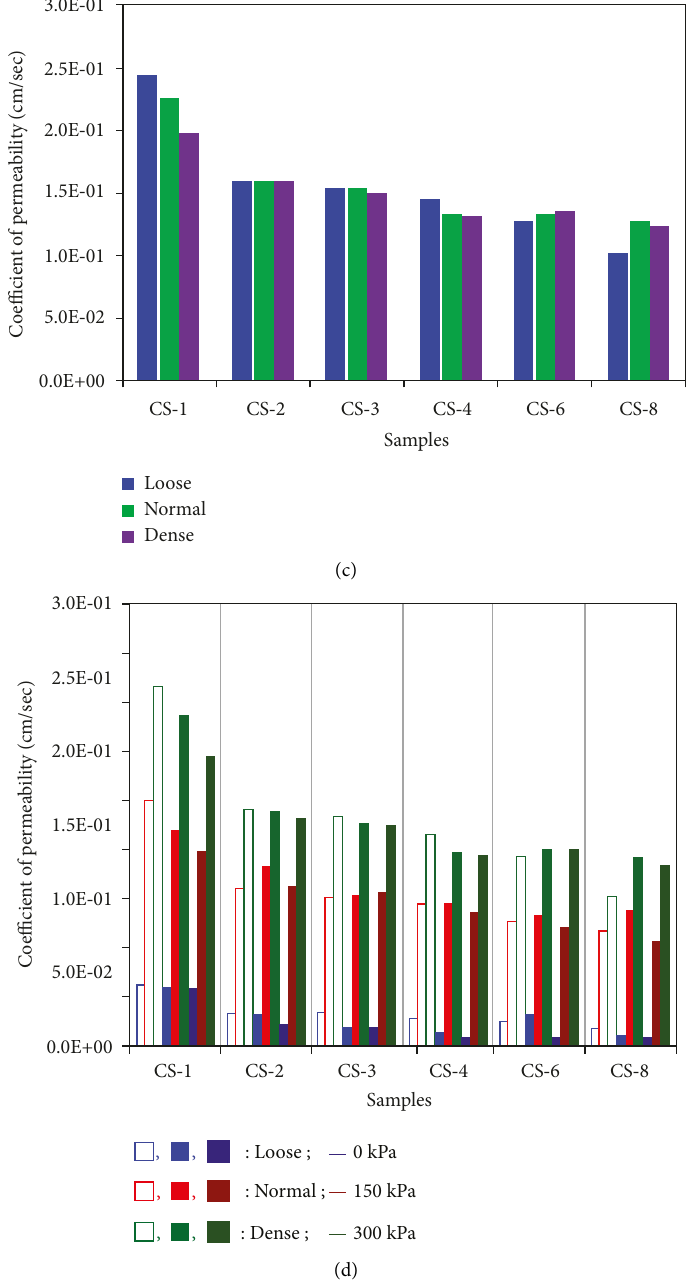
Figure 9: Coefficient of permeability of the samples according to the compaction condition. (a) Loose. (b) Normal. (c) Dense. (d) Pressure vs mixing